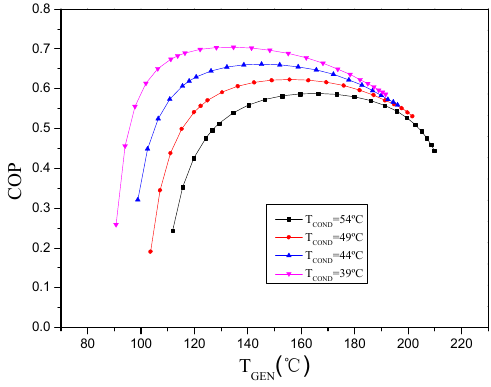
ff erent T COND .